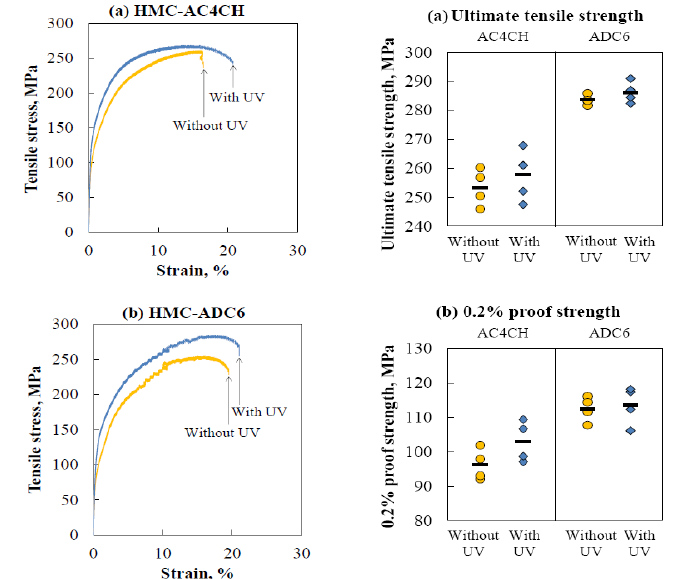
Figure 9. ( a ) Tensile properties of HMC–AC4CH and ( b ) HMC–ADC6 with and